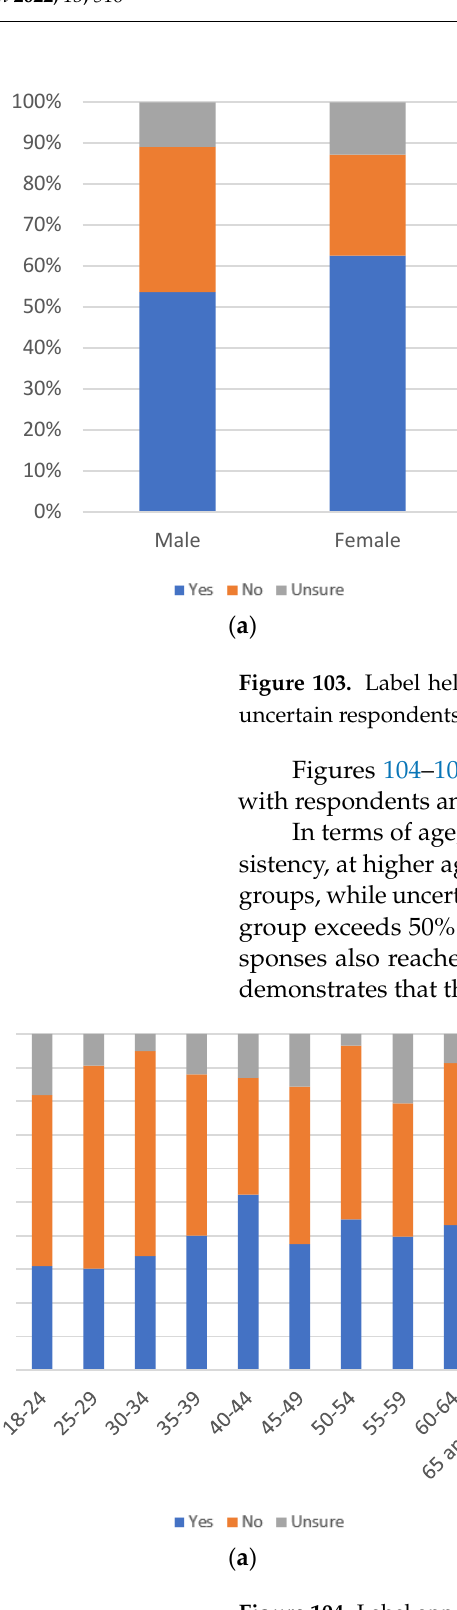
( b ) Figure 105. Label annoyingness, by education level: ( a ) with uncertain respondents (left) and ( b ) without uncertain respondents (right).